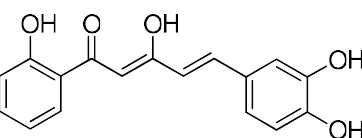
Figure 1. Chemical structure of 5-(3,4-dihydroxyphenyl)-3-hydroxy-1-(2-hydroxyphenyl)penta-2,4-dien-1-one ( DHHPD ).